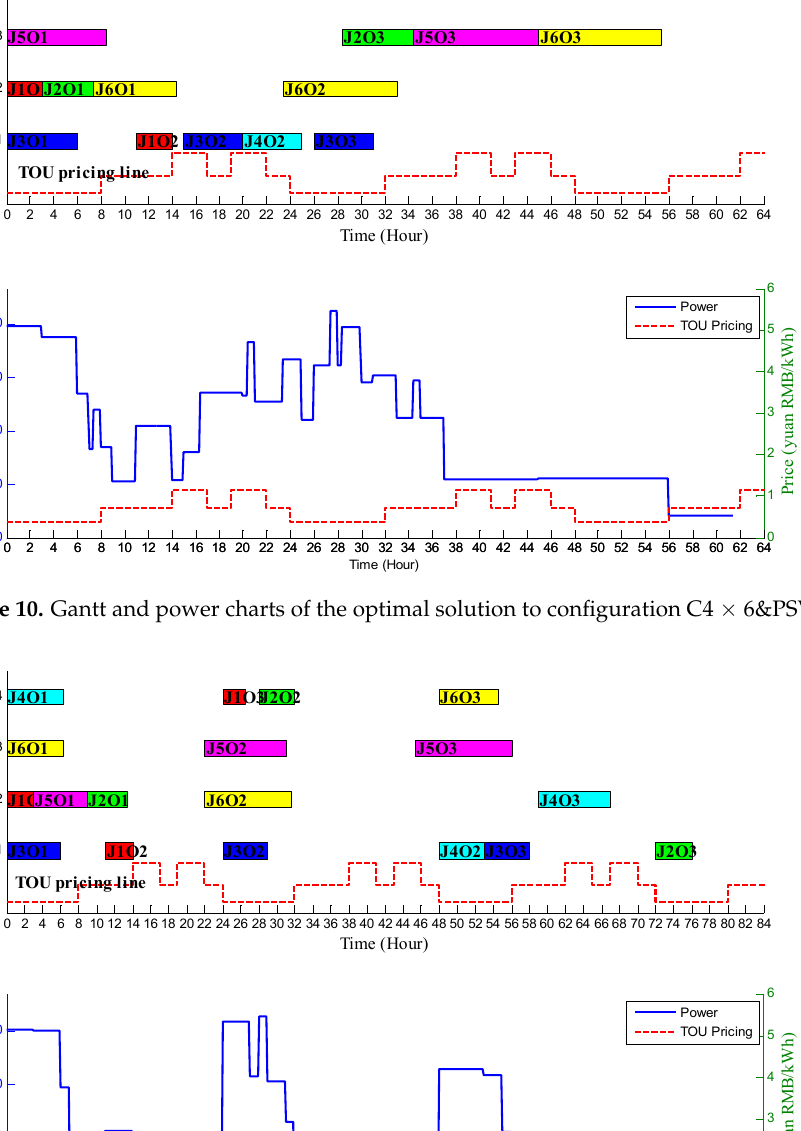
Figure 9. Gantt and power charts of the optimal solution to configuration C4 × 6&OPF.